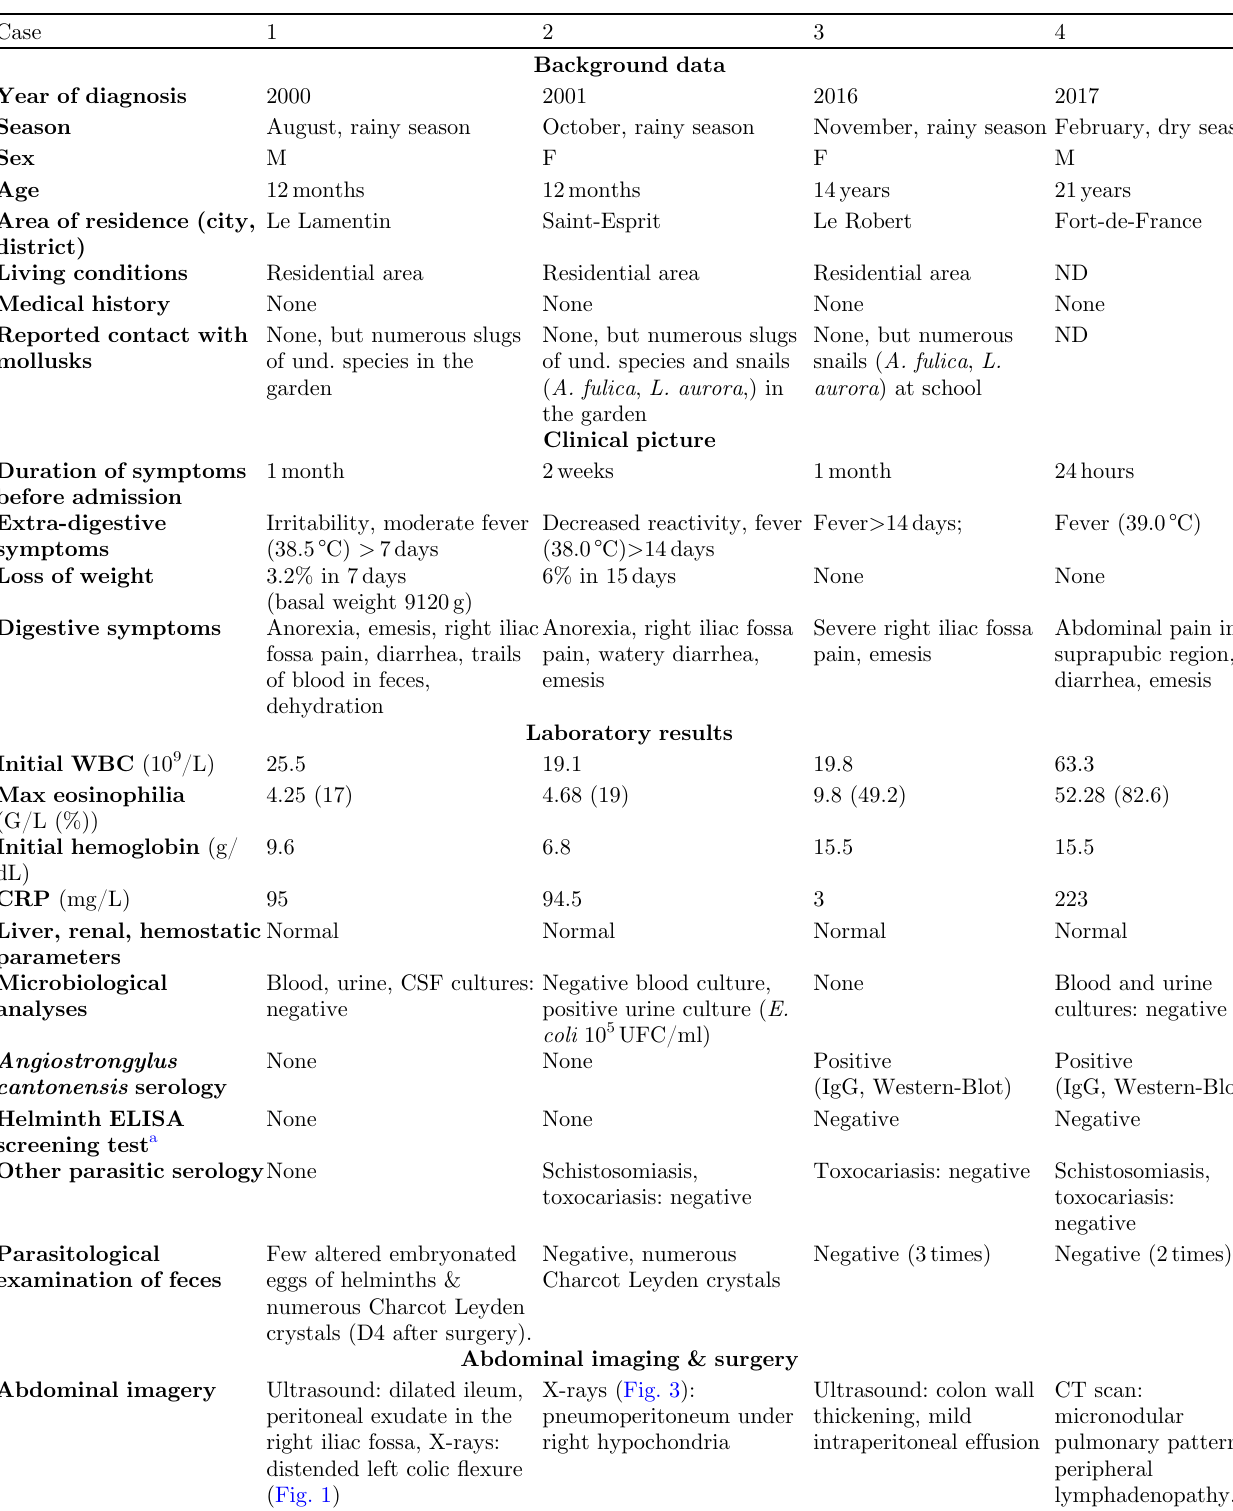
Table 1. Clinical characteristics of the four patients with con fi rmed (cases 1 and 2) and probable (cases 3 and 4) Angiostrongylus costaricensis infection in Martinique. A. fulica : Achatina fulica , CRP: C-reactive protein, CSF: Cerebrospinal fl uid, CT